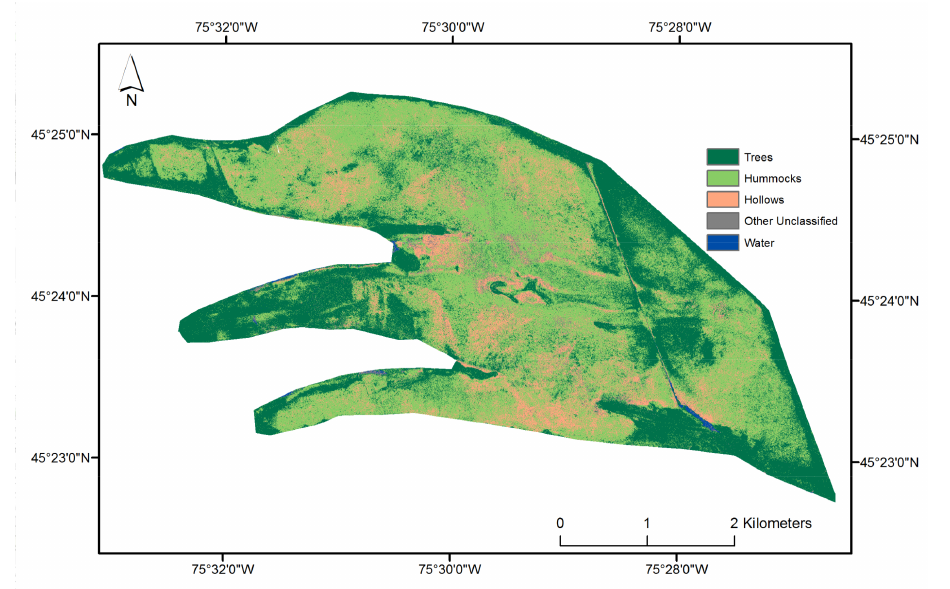
Figure 5. Distribution of peatland microform and tree classes for Mer Bleue based on CASI imagery from 23 June